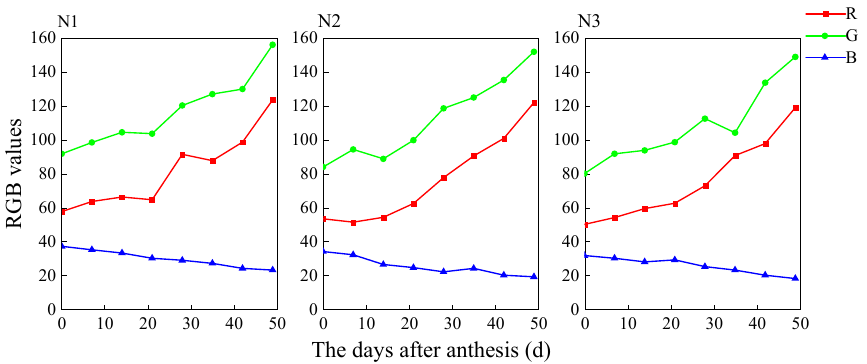
Figure 2. Dynamic changes in leaf RGB values with high, medium, or low nitrogen supplies in HD5 after anthesis.